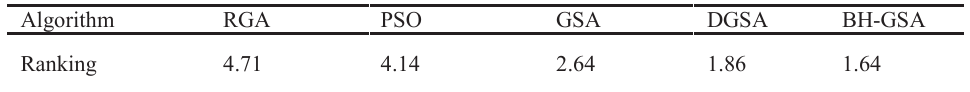
Table 9. Average ranking of algorithms based on the average best-so-far for unimodal test functions of set 1. Algorithm